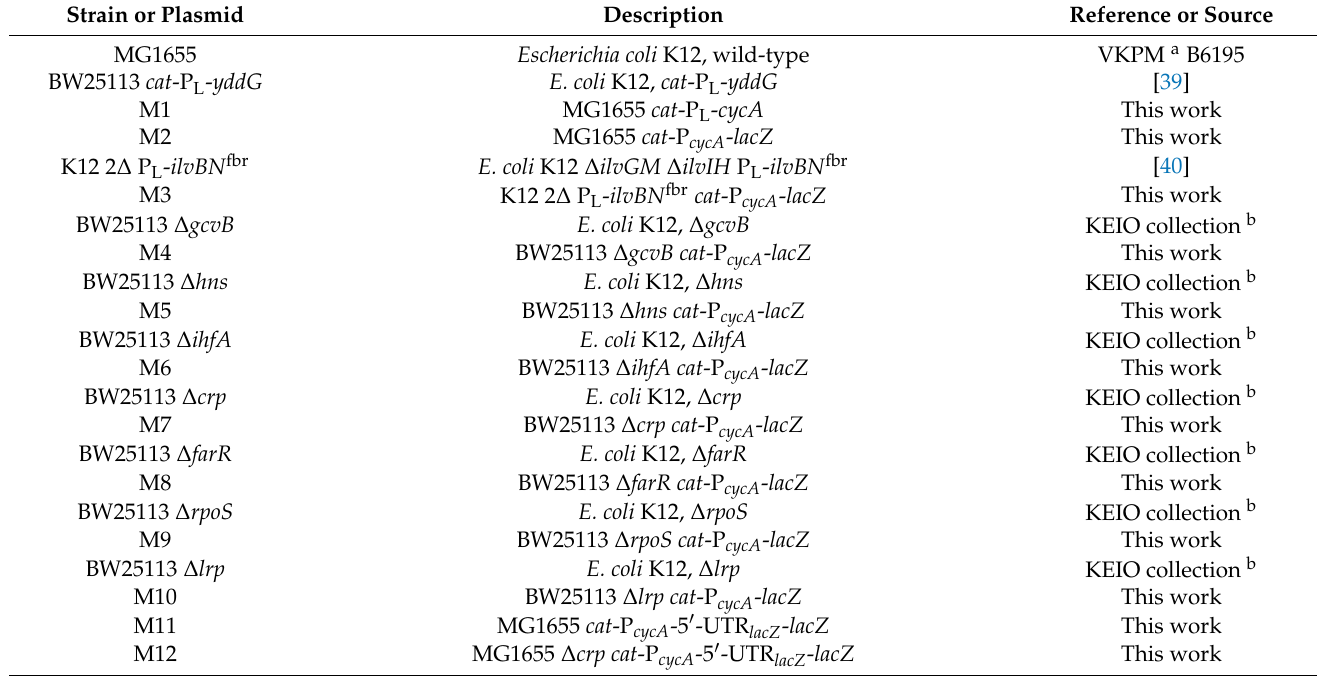
Table 1. Bacterial strains and plasmids used in this